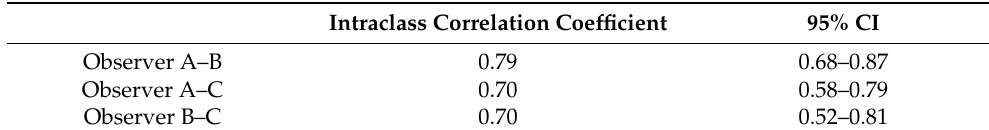
Table 2. Correlation between the mean symphysis–ischial spine distance (SID) measurements made by the three observers (A, B and C) and the 95% confidence intervals (CI).